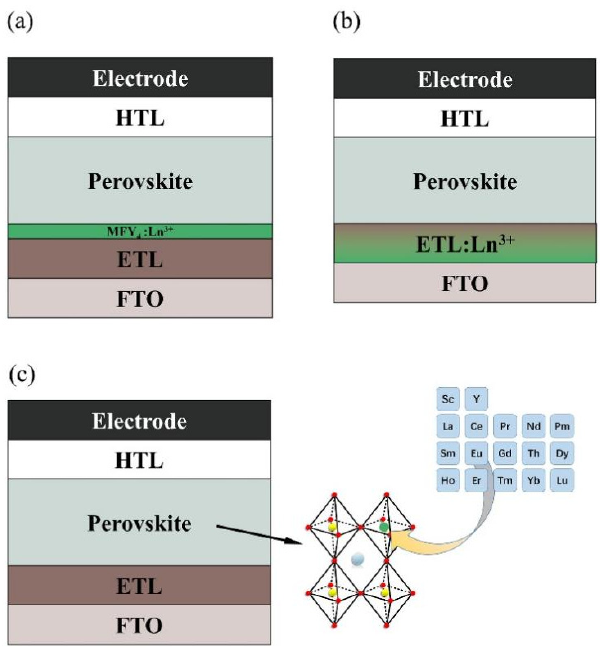
Figure 1. Three modified strategies of Ln 3+ in perovskite device: ( a ) Inserting Ln 3+ -based conversion layer in perovskite device; ( b ) Ln 3+ ion mixed into carrier transport layer; ( c ) Ln 3+ ion doped in perovskite active layer.